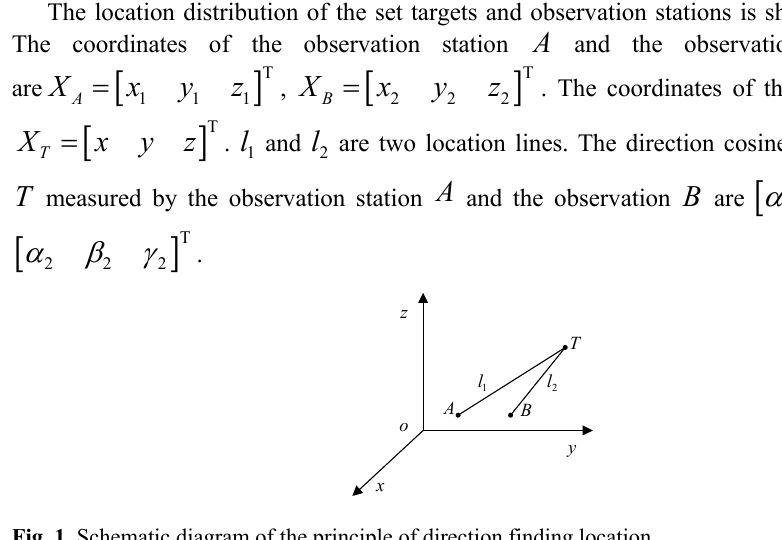
Fig. 1. Schematic diagram of the principle of direction finding